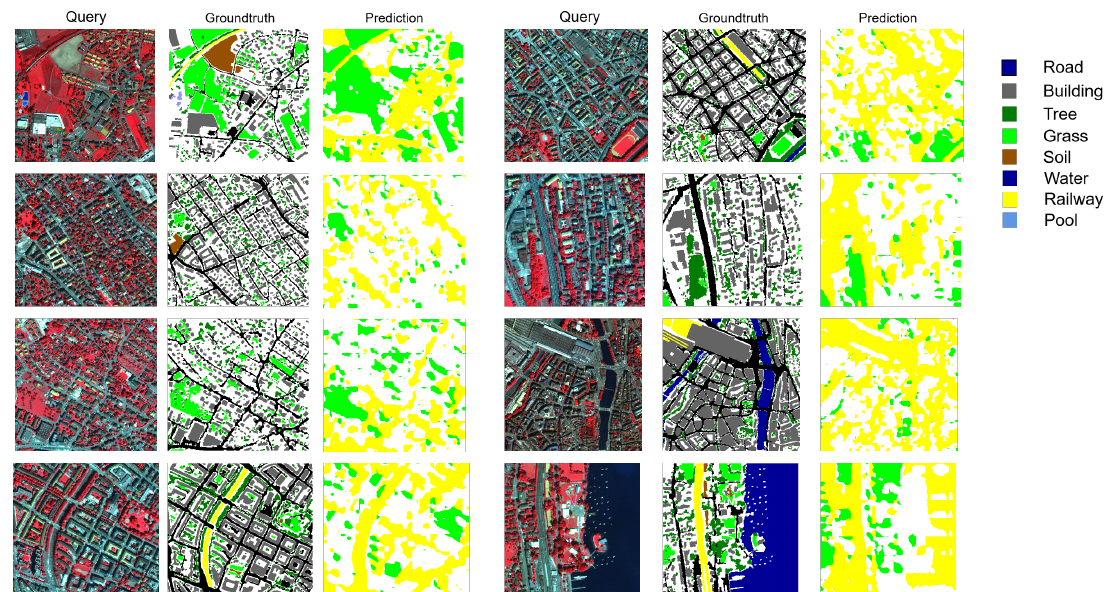
Figure 5. Qualitative outcomes of our method on Zurich